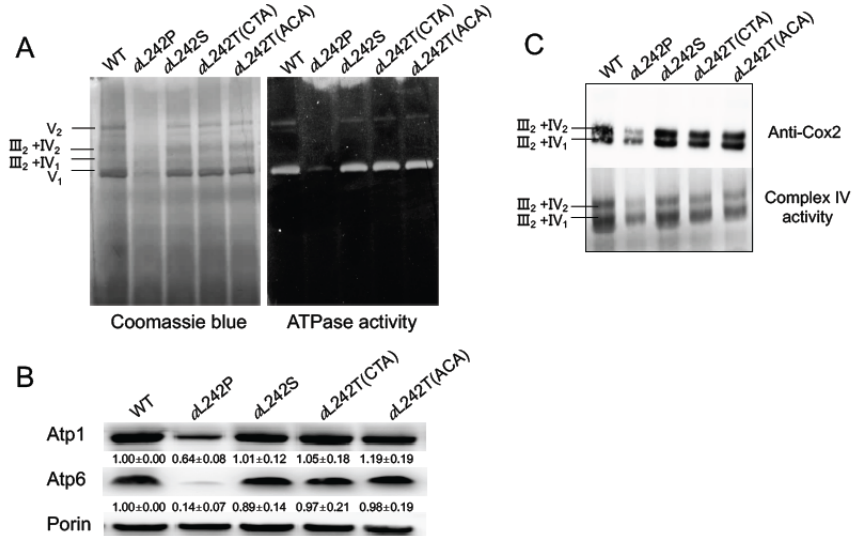
Figure 2. Assembly of OXPHOS complexes. For these experiments mitochondria were isolated from wild type ( WT ) and the mutant strains a L242P, a L242T and a L242S grown for 24 h at 28 ◦ C in rich galactose liquid media until a density of 2-3 OD 600nm . ( A ) Mitochondria were solubilized with 2 g of digitonin / g protein, and samples of 250 µ g were separated by BN-PAGE in a 3–12% acrylamide gel. In the left panel the proteins are stained with Coomassie blue; in the right panel, F 1 F O complexes are revealed in-gel by their ATPase activity. ( B ) Total mitochondrial proteins were resolved by SDS-PAGE analysis (50 µ g per lane), transferred to a nitrocellulose membrane and probed with antibodies against the indicated proteins. Values are normalized to porin and expressed relative to WT ± standard deviation. ( C ) Mitochondria were solubilized with 10 g of digitonin/g protein, and samples of 250 µ g were separated as in (A) and then transferred to a PVDF membrane. Oligomers of Complex IV associated to complex III (III 2 -IV 2 and III 2 -IV 1 ) were probed with antibodies against the Cox2 subunit of Complex IV (upper panel) and in-gel by the activity of Complex IV (lower panel). The shown gels are representative of at least 3 experiments.